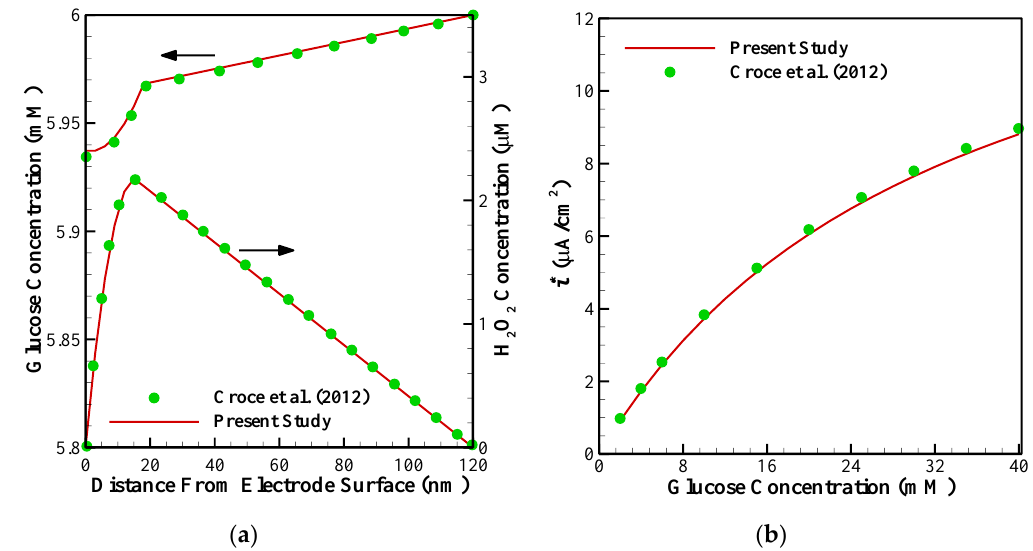
Figure 4. Comparison between the results of the present study with [13]: ( a ) concentration profiles of glucose and H 2 O 2 in a multi-layer sensor system consisting of GO x /PPD (20 nm) and HAs/Fe 3+ (100 nm); ( b ) dependency of the maximal current of the biosensor on the glucose concentration with 20 nm of GO x /PPD and 100 nm of HAs/Fe 3+ .